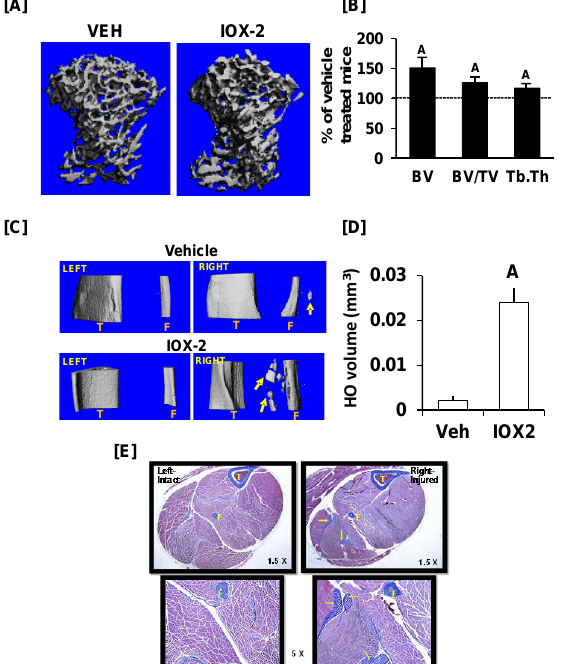
Figure 2. Illustration and quantitation of trabecular bone parameters and HO formation in the fibula-muscle injury mice response to IOX2 treatment. ( A ) Micro-CT image of trabecular bone mass at the secondary spongiosa in the fibula-muscle injury mice treated with vehicle or IOX2, ( B ) quantitation of trabecular bone parameters in 22-week-old fibula-muscle injury mice treated with vehicle or IOX2, ( C ) micro-CT image of HO indicated with arrows near the fibula cut region, ( D ) quantitation of HO volume by micro-CT, and ( E ) trichrome staining of HO near the fibula cut region by histology. T—tibia and F—fibula. Values are the mean ± SEM. N = 5, A p < 0.05 vs. control.